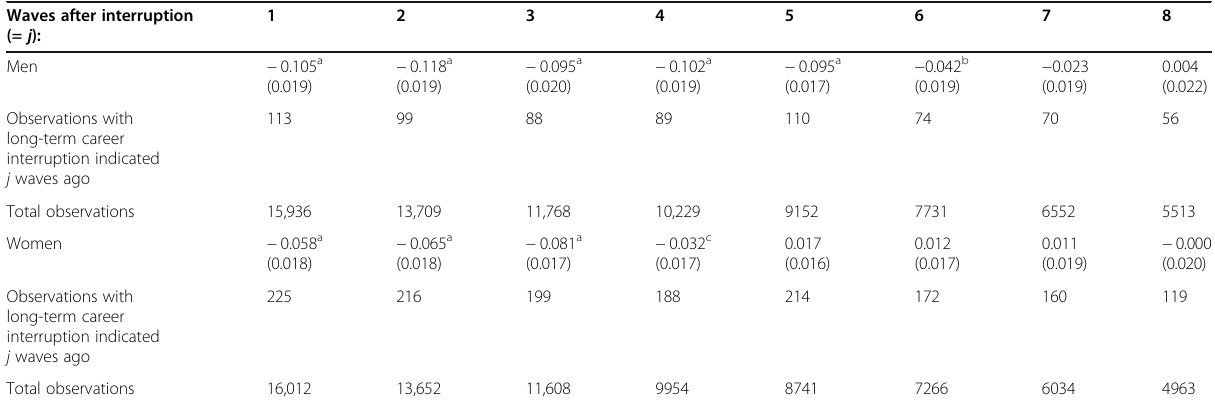
Table 6 Future wage effects of a long-term non-employment spell for men and women. Dependent variable: log real hourly wage, j waves after the